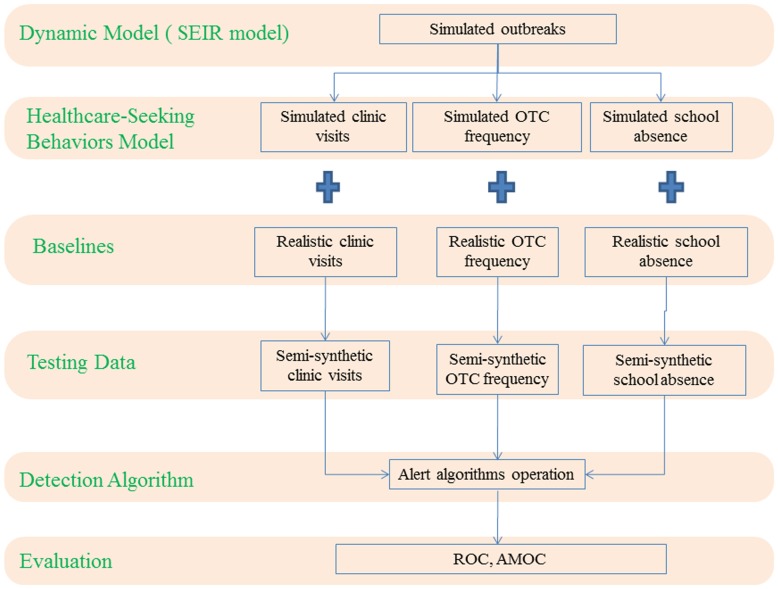
Schematic diagram of multi-stream evaluation based on healthcare-seeking behaviors model for performance on outbreak detection.First, simulated outbreak datasets are generated by the SEIR model. Second, the simulated outbreak datasets are converted into three kinds of syndromic datasets according to a discrete distribution probability of healthcare-seeking behaviors. Third, the converted syndromic datasets are superimposed onto corresponding syndromic baseline datasets to create testing datasets. Next, detection algorithms can be performed on testing datasets to detect simulated outbreaks. Last, relevant indicators can be devised to evaluate the detection performance. OTC: over-the-counter; ROC: receiver operating characteristic; SEIR: Susceptible – Exposed – Infectious – Recovered model; AMOC: activity monitoring operation curves.